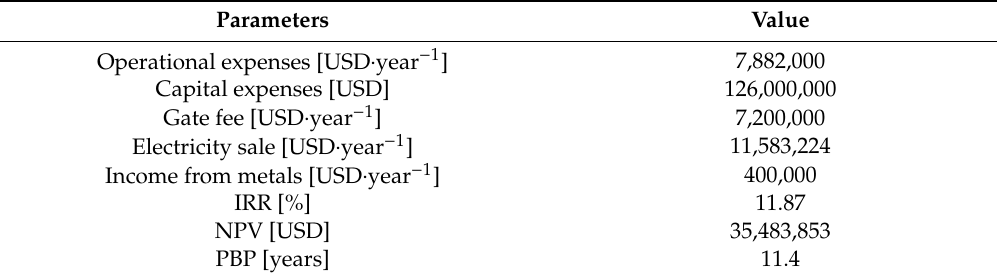
Table 5. Financial performance of the waste-to-energy